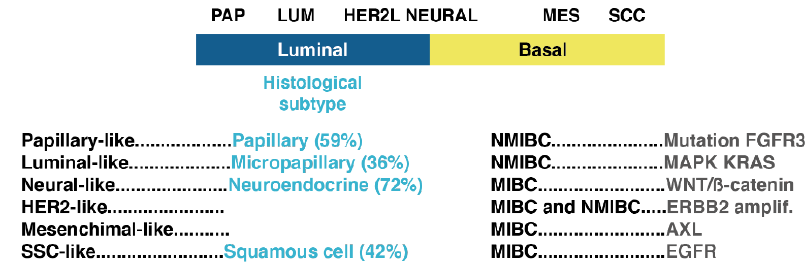
Figure 4. Molecular subtypes and the corresponding histological subtypes (frequency in parenthe- sis). PAP: papillary; LUM: luminal; MES: mesenchymal; SCC: squamous-cell carcinoma-like; NMIBC: non-muscle-invasive bladder cancer; MIBC: muscle-invasive bladder cancer (modified from Tan et al. [31]).